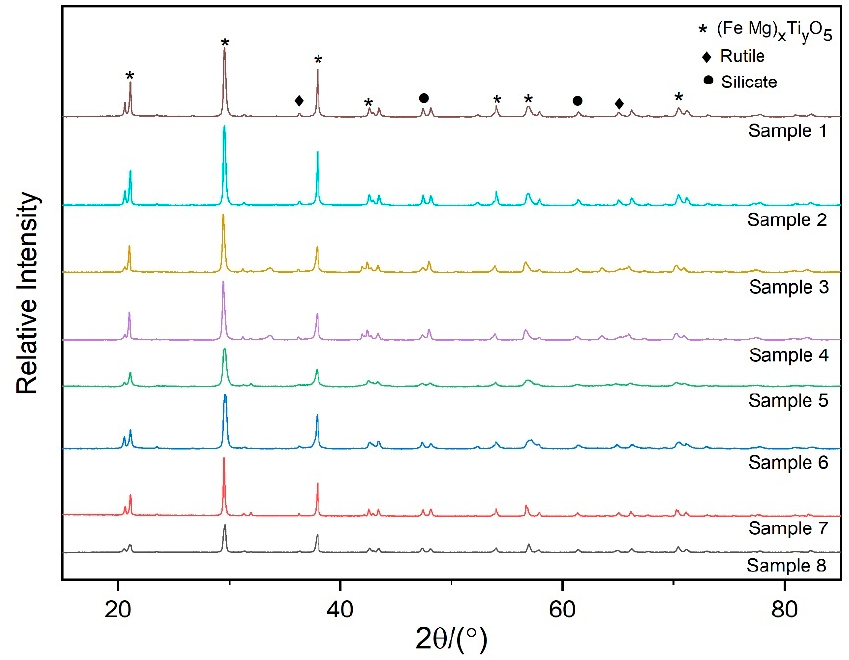
Figure 2. X-ray powder diffraction (XRD) patterns of sample 7 and sample 8.